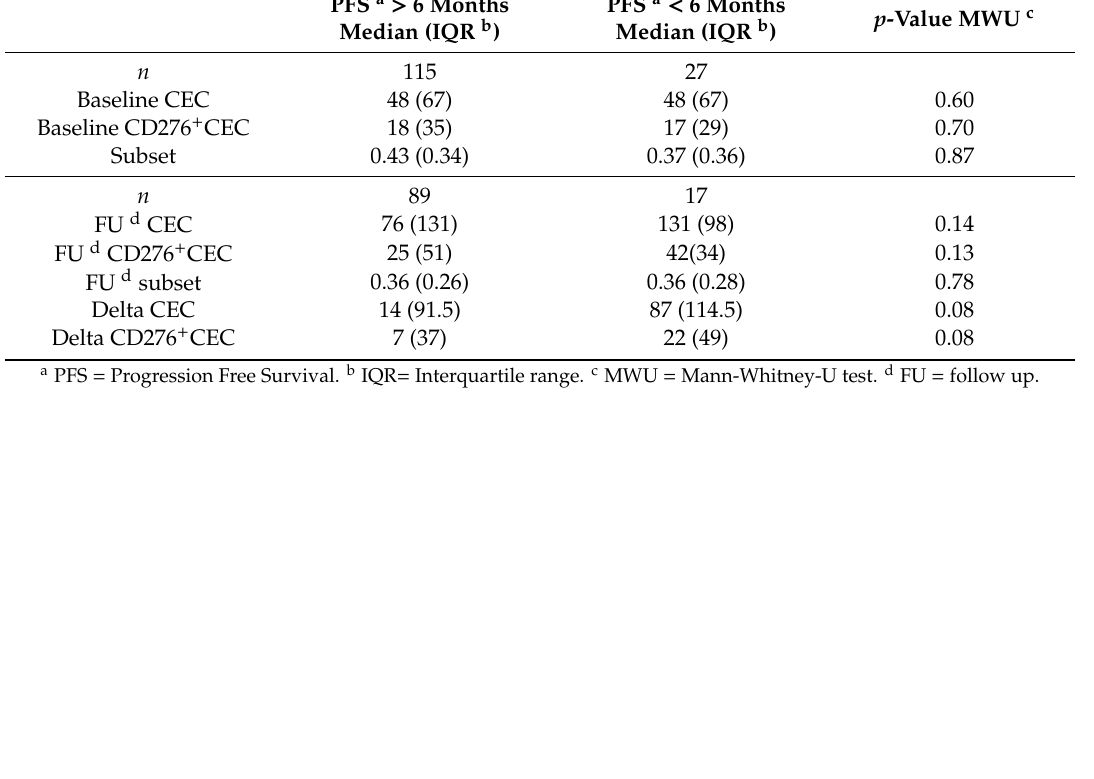
Table 2. Response prediction of (CD276 + )